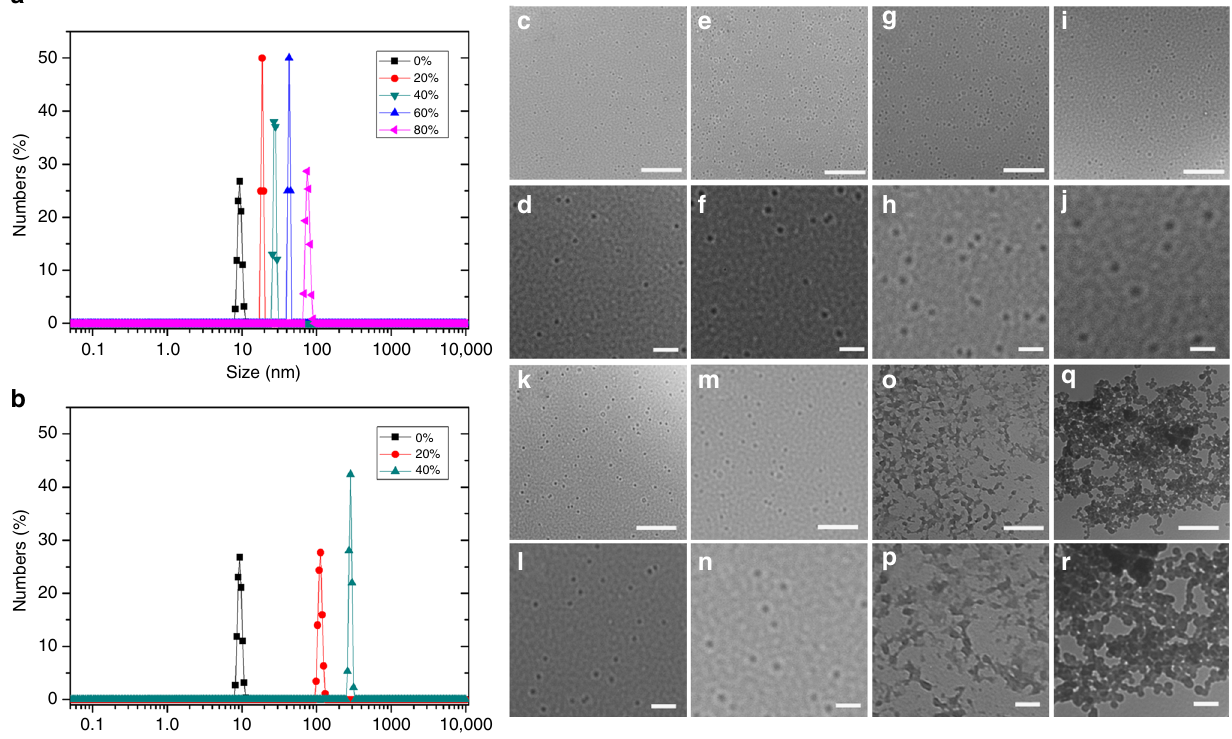
Fig. 7 DLS data and TEM images of G2 aggregates. Size distribution of G2 in a acetonitrile/methanol, and b acetonitrile/water mixtures by DLS (the percentages in the graphs are the poor solvent contents); TEM images of the aggregates of G2 formed in acetonitrile/methanol mixtures containing c , d 20%, e , f 40%, g , h 60%, and i , j 80% methanol (scale bar 500 nm for the upper images and 100 nm for the lower images, respectively), and aggregates of G2 formed in acetonitrile/water mixtures containing k , l 20% (scale bar, 2 μ m and 500 nm, respectively), m , n 40% (scale bar, 2 μ m and 500 nm, respectively), o , p 60% (scale bar, 1 μ m and 500 nm, respectively), and q , r 80% water (scale bar, 1 μ m and 500 nm,